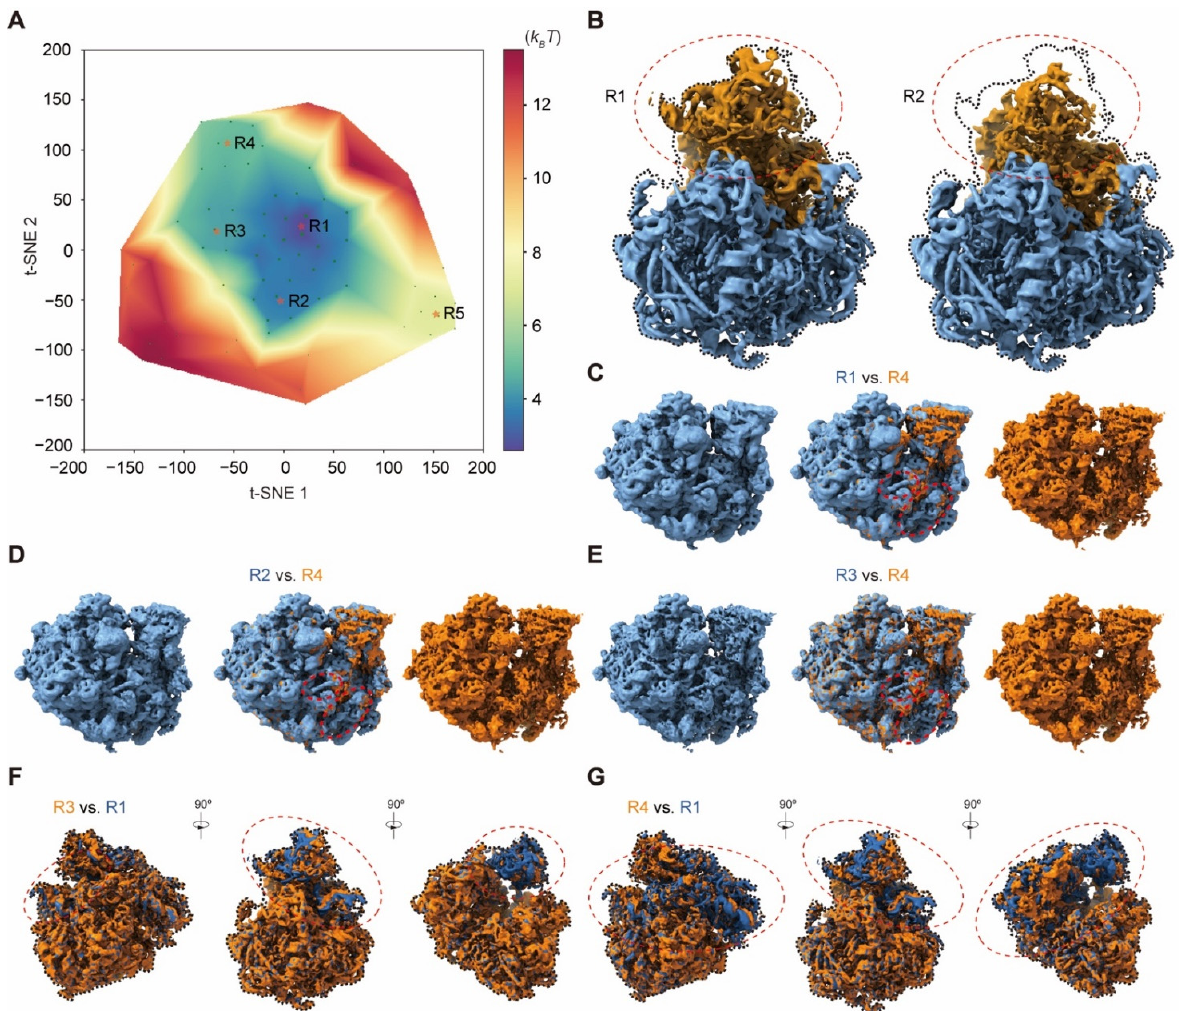
Figure 7. Visualizing hidden conformational dynamics of the Pf 80S ribosome bound to the anti- protozoan drug at high resolution by AlphaCryo4D. ( A ) Clusters R1-R5 on the pseudo-energy landscape by AlphaCryo4D. Energy-based particle voting was conducted within each cluster to keep particles of high reproducibility. ( B ) Comparison of the density maps of clusters R1 and R2. Cluster R1 is the major state in the Pf 80S ribosome dataset, while cluster R2 accounts for the state missing the head of 40S (red circles). The dynamic region of the density map is colored orange and the stable region is colored blue. ( C – E ) Comparisons of states R1 and R4 ( C ), states R2 and R4 ( D ) and states R3 and R4 ( E ) reveal the differential appearance of the C-terminal helix of eL8 and an rRNA helix. Note that the rRNA helix is only partially presented in state R3. ( F ) State R3 superimposed with state R1 from three different viewing angles. The density of the 40S head region (red circles) rotated relative to the 60S. ( G ) State R4 superimposed with state R1 from three different viewing angles. The density of the whole 40S (red circles) is rotated relative to the 60S (Supplementary Video S2).